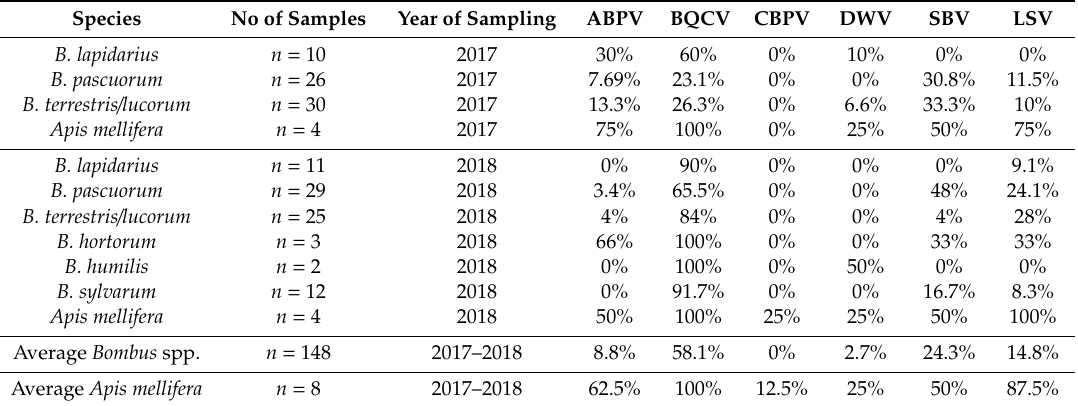
Table 1. The percentage of detected Bombus lapidarius , B. pascuorum , B. terrestris / lucorum B. hortorum, B. humilis, B. sylvarum and Apis mellifera positive samples for ABPV, BQCV, CBPV, DWV, SBV and LSV by specific RT-PCR methods, collected in August 2017 and